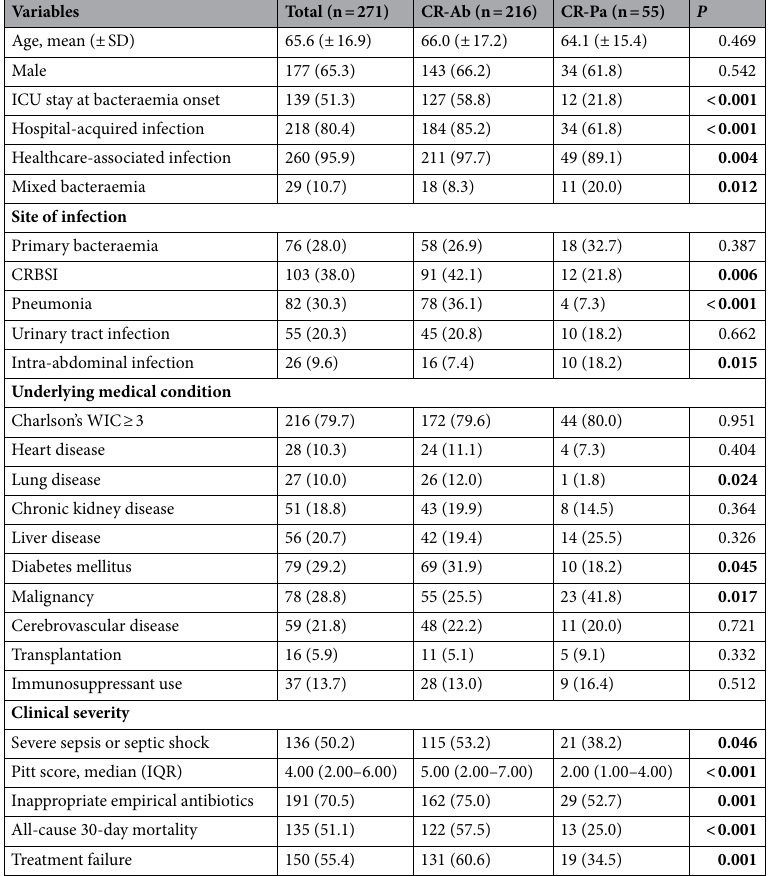
Table 1. Clinical characteristics of patients with carbapenem-resistant Acinetobacter baumannii (CR-Ab) and carbapenem-resistant Pseudomonas aeruginosa (CR-Pa) bacteraemia. SD, standard deviation; ICU, intensive care unit; CRBSI, catheter-related bloodstream infection; WIC, weighted index of comorbidity; IQR, interquartile range. Significant values are in [bold].